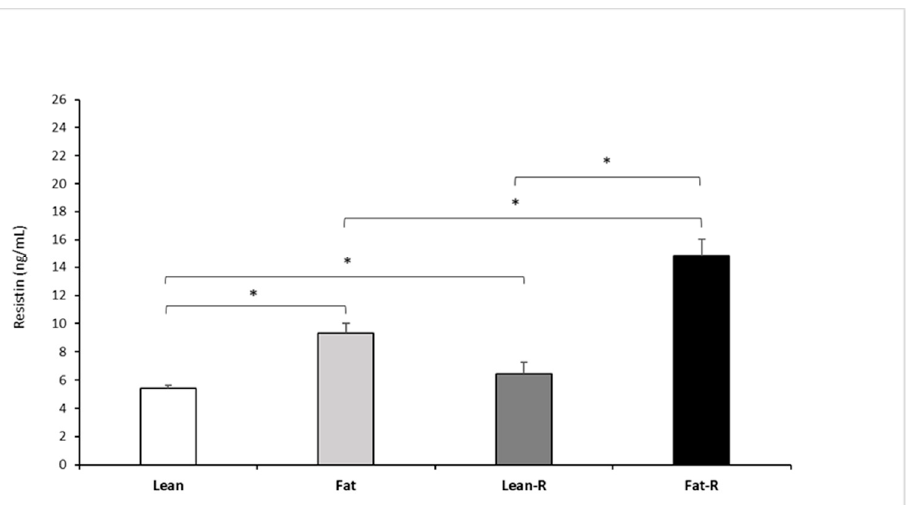
Figure 5. Plasma resistin concentrations. Mean concentrations of circulating ( ± SEM) of resistin in non ‐ treated (Lean and Fat) animals and animals treated with recombinant bovine resistin (Lean ‐ R and Fat ‐ R) after 5 months of body weight alteration (n = 5 per group). * p < 0.05 denotes difference between groups.